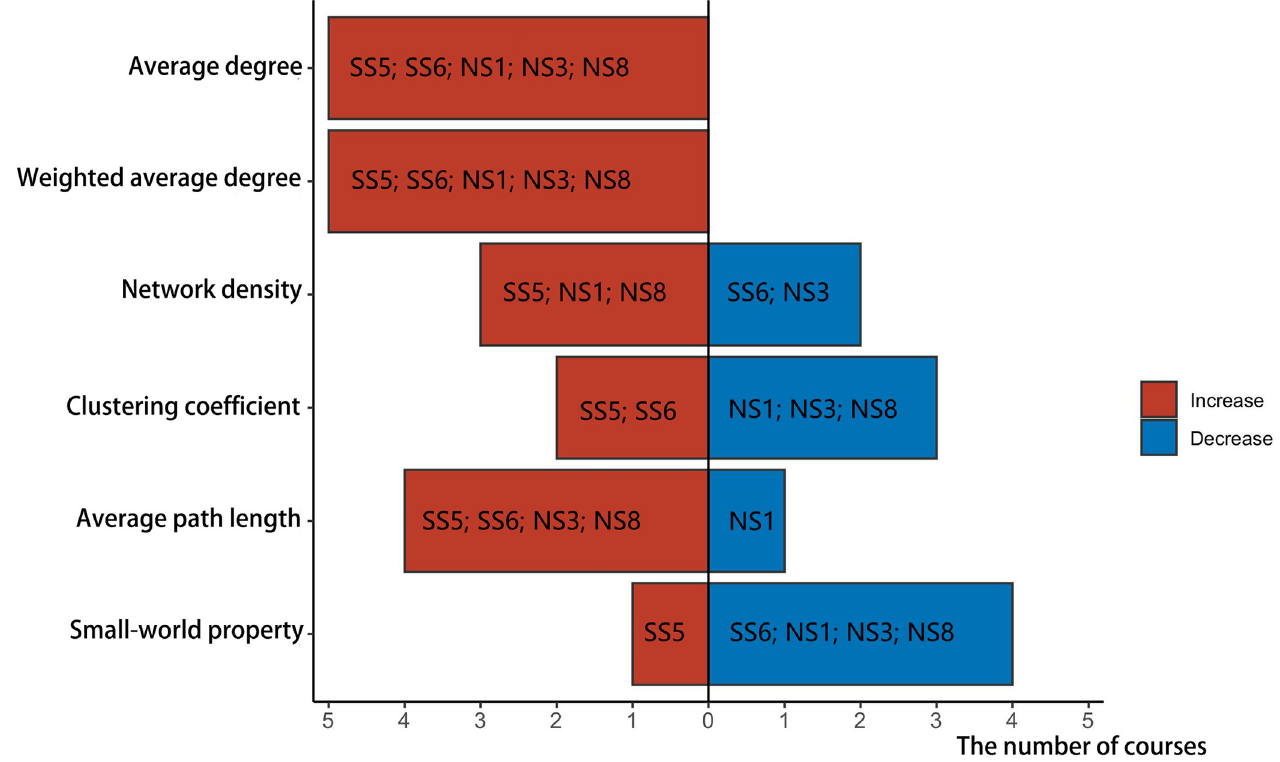
Fig 3. Indicator changes in courses with increased interaction scale from before the COVID-19 outbreak until the outbreak. https://doi.org/10.1371/journal.pone.0273016.g003 Only the weighted average degree of the course network increased. The average degree, net- work density decreased, indicating that network members were not active and that learners’ interaction degree and communication frequency lessened. Despite reduced learner interac- tion, the average path length was small and the connectivity between learners was adequate.